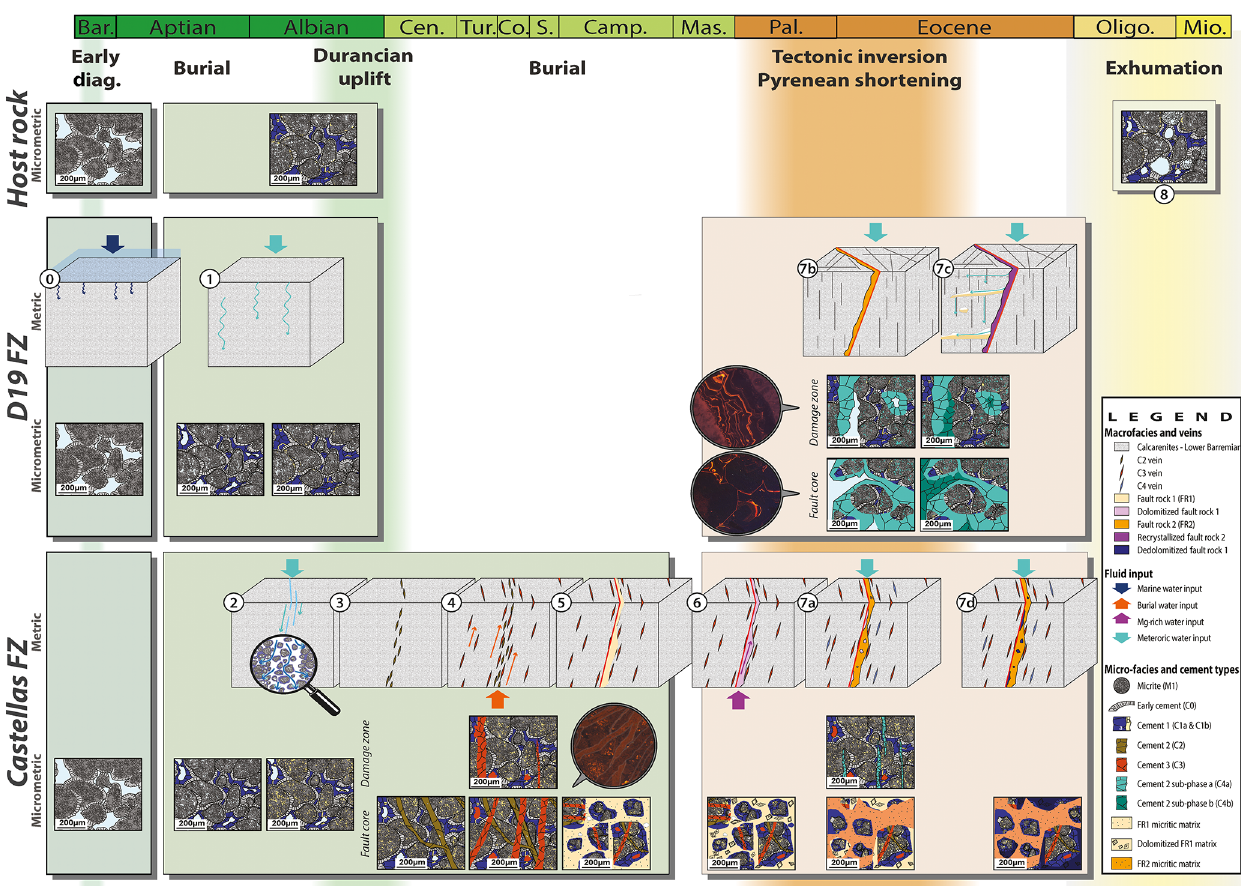
Figure 8. Diagenetic and geodynamic evolution since the Barremian of both fault zones and host rock at the metric and micrometric scale. Numbers 0 to 8 correspond to the Steps 0 to 8 (see text for